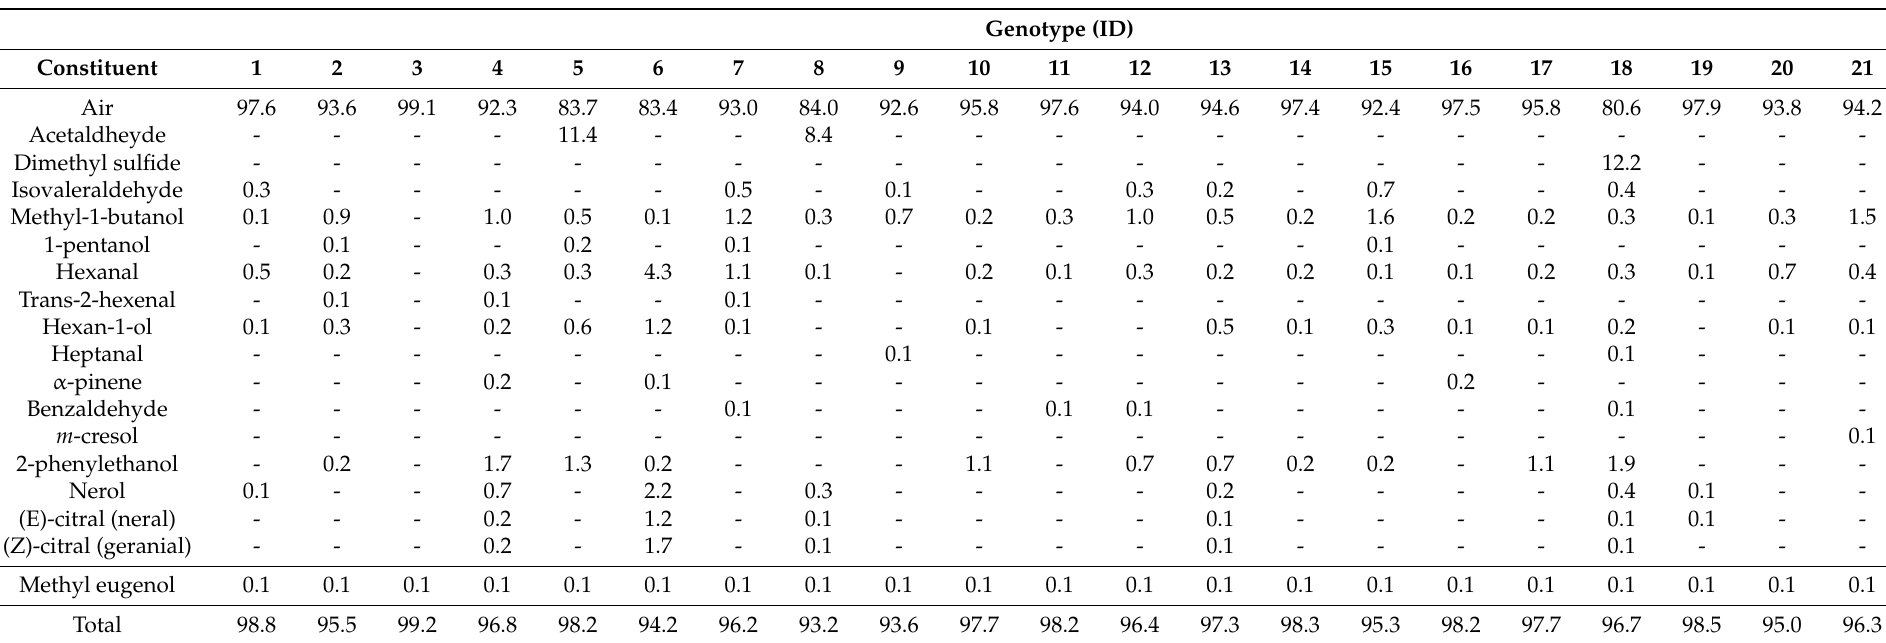
Table 4. Chemical composition and the percentage of relative peak area (%) of volatiles emitted from pollen of the 21 studied rose genotypes (see Table 1). All constituents are ordered on the basis of their retention time (see Table